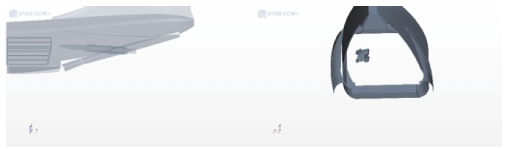
Figure 26: Missile movement posture at 0.2s.